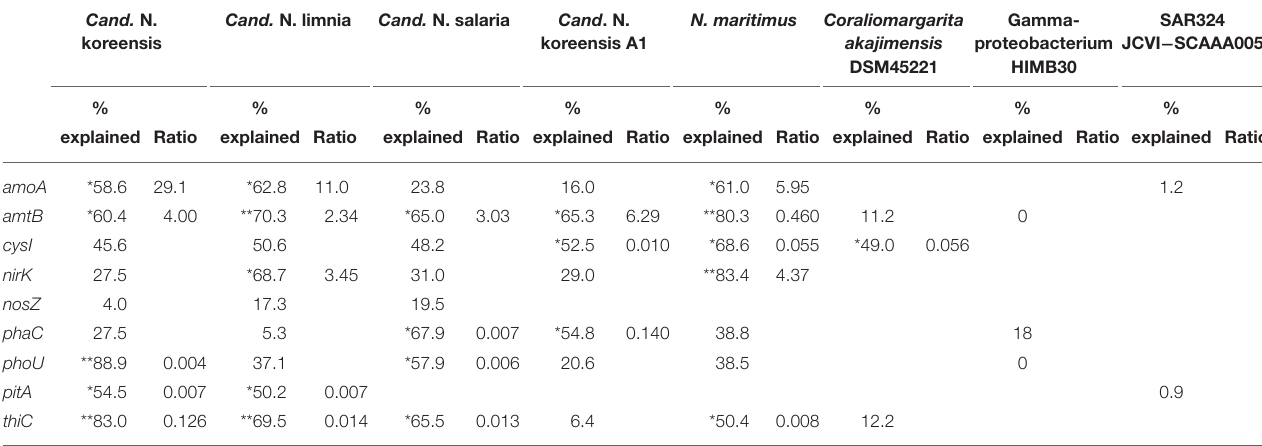
TABLE 3 | Regression statistics for plots of transcripts L − 1 against genes L − 1 for nine biogeochemically relevant genes in homogeneous genome bins. Cand. N.